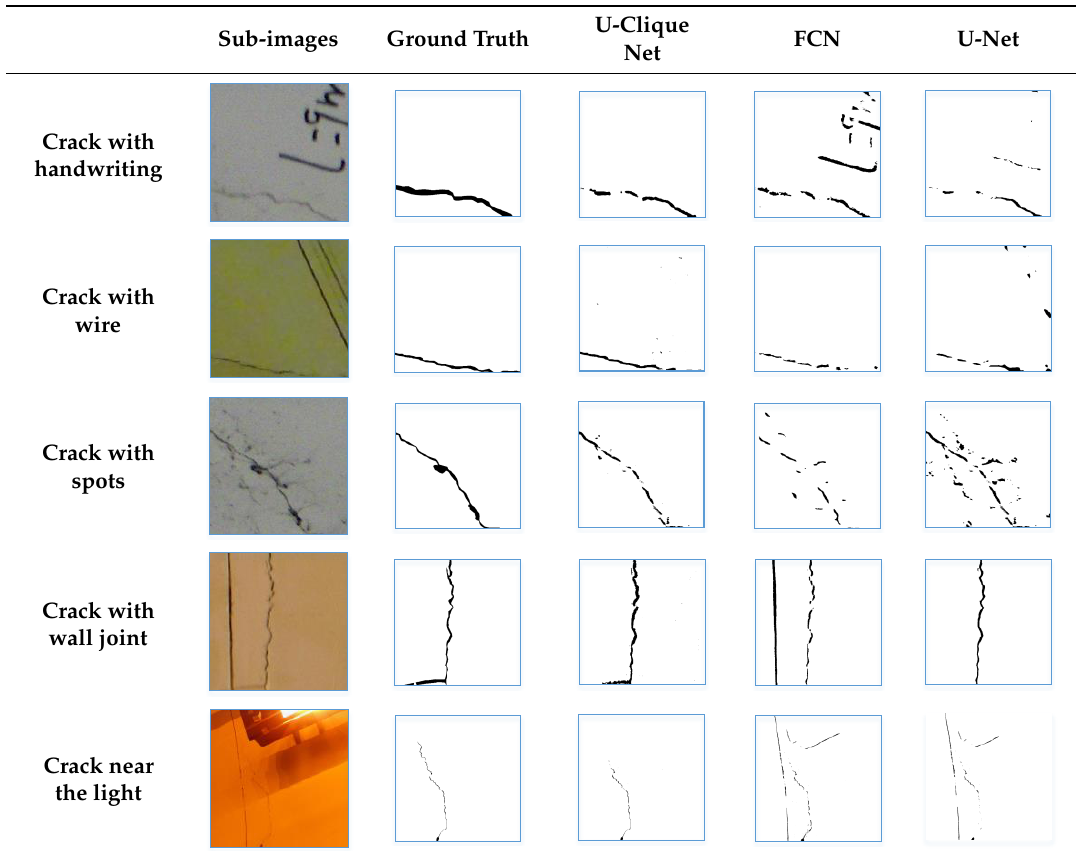
Table 6. Prediction result of cracks with different noises.